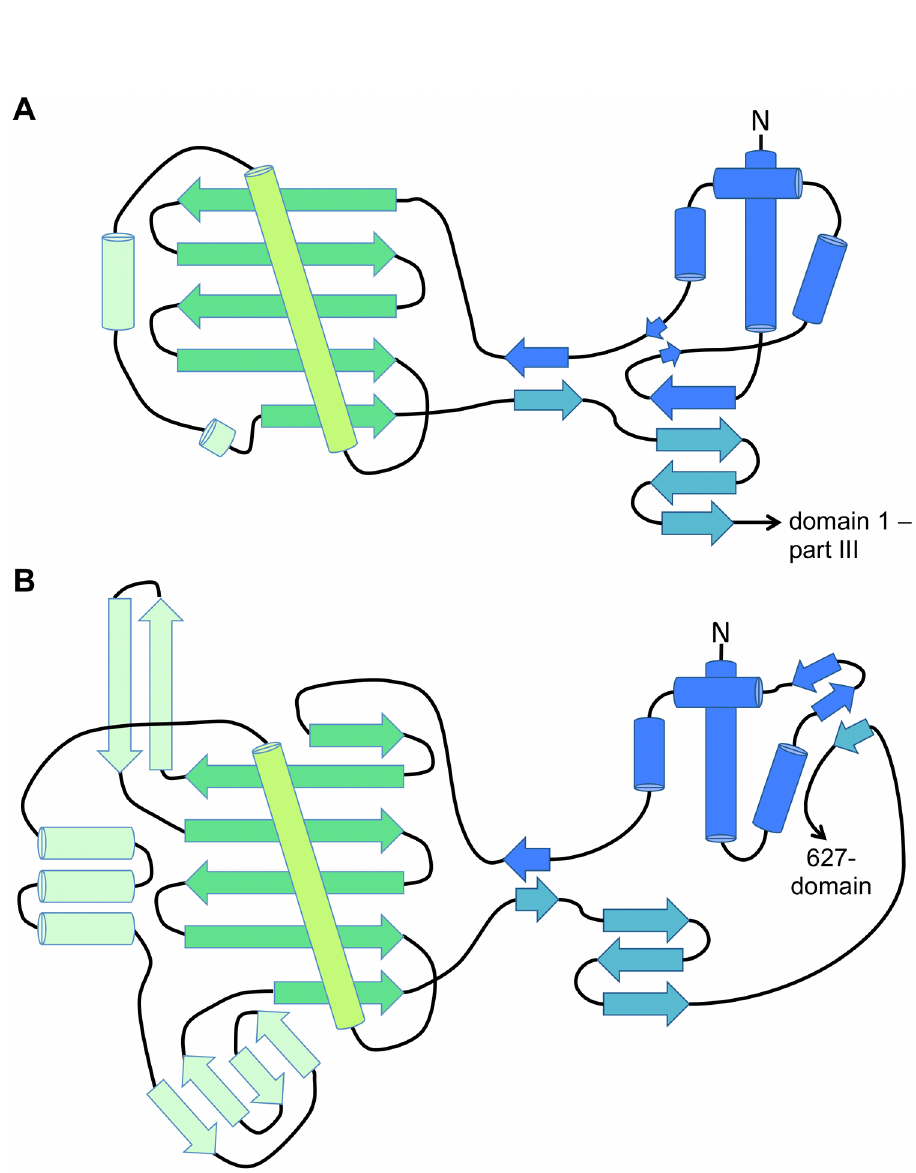
Fig 3. Topological overview of CASV L-Cterm and influenza virus PB2 structures. A schematic representation of the generaldomainarchitecture of A) CASV L-Cterm domain1 –parts I and II (coloredin blue and teal, respectively)and domain2 (coloredin greens) as well as of B) influenza virus PB2 mid-domain (blue), cap-binding-domain(greens) and linker-domain(teal). α -Helicesare shown as cylinders, β -strands as large arrows. The N-terminiare labelledand the protein parts that follow the representeddomainsare indicatedby a small arrow with names given.